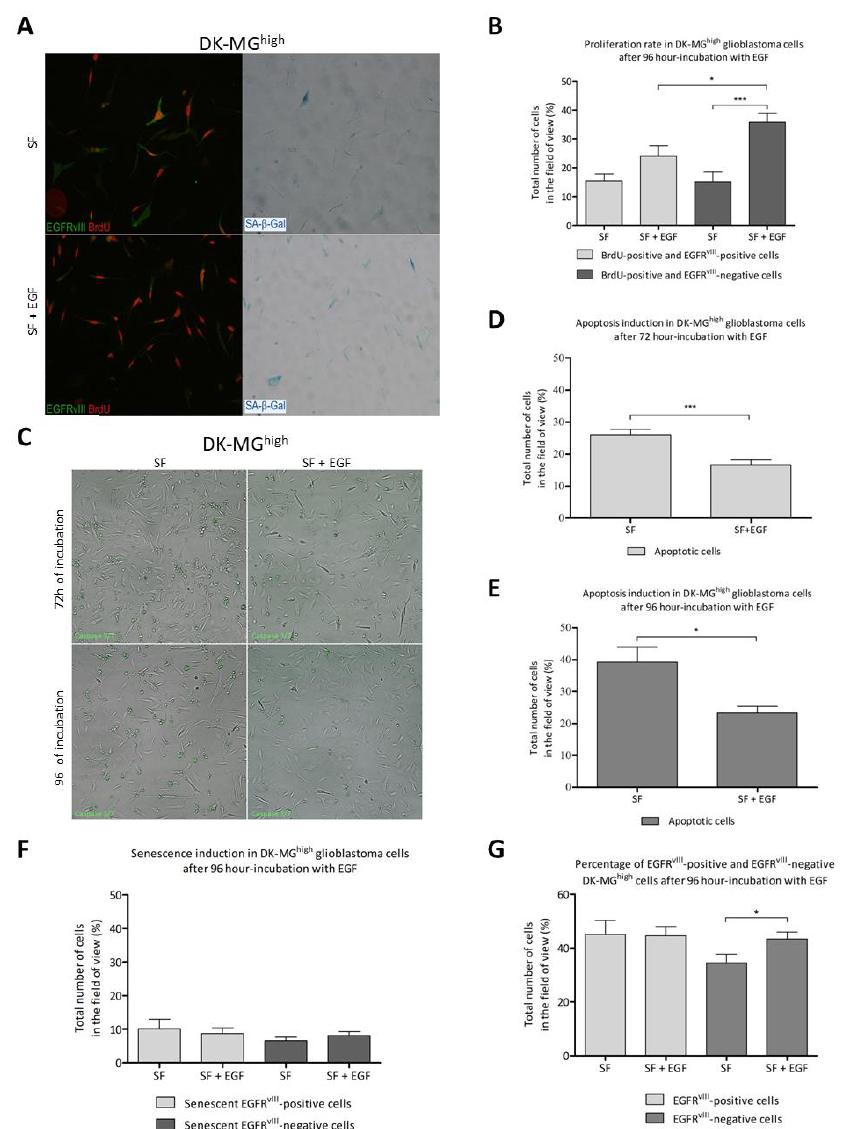
Figure 3. The influence of EGF on senescence induction, proliferation rate, apoptosis, and EGFR vIII expression in DK-MG high glioblastoma cells in vitro. Representative images showing the impact of EGF on cellular proliferation and senescence in DK-MG high glioblastoma cells; magnification 400 × ( A ). Comparison of the percentage of proliferating EGFR vIII -positive and EGFR vIII -negative cells after 96 h of incubation with 20 ng/mL EGF (SF (serum free)+ EGF) and without EGF (SF) ( B ). Representative images showing the EGF influence on apoptosis induction in DK-MG high glioblastoma cells after 72 and 96 h of incubation with epidermal growth factor; magnification 40 × ( C ). Comparison of the percentage of apoptotic glioblastoma cells after 72 h of incubation with 20 ng/mL EGF (SF + EGF) and w/o EGF (SF) ( D ). Comparative analysis of apoptosis induction in DK-MG high cells in response to 96-h treatment with 20 ng/mL EGF (SF + EGF) and w/o EGF (SF) ( E ). Comparative analysis of senescence induction in both EGFR vIII -positive and EGFR vIII -negative DK-MG high cells in response to 96-h treatment with 20 ng/mL EGF (SF + EGF) and w/o EGF (SF) ( F ). The percentage of EGFR vIII -positive and EGFR vIII -negative cells after 96-h incubation with EGF (SF + EGF) and w/o EGF (SF) ( G ). SF–serum free medium/serum-free conditions. Comparison 20 × objective used. Statistical significance was considered at p < 0.05, “*”; p < 0.001,